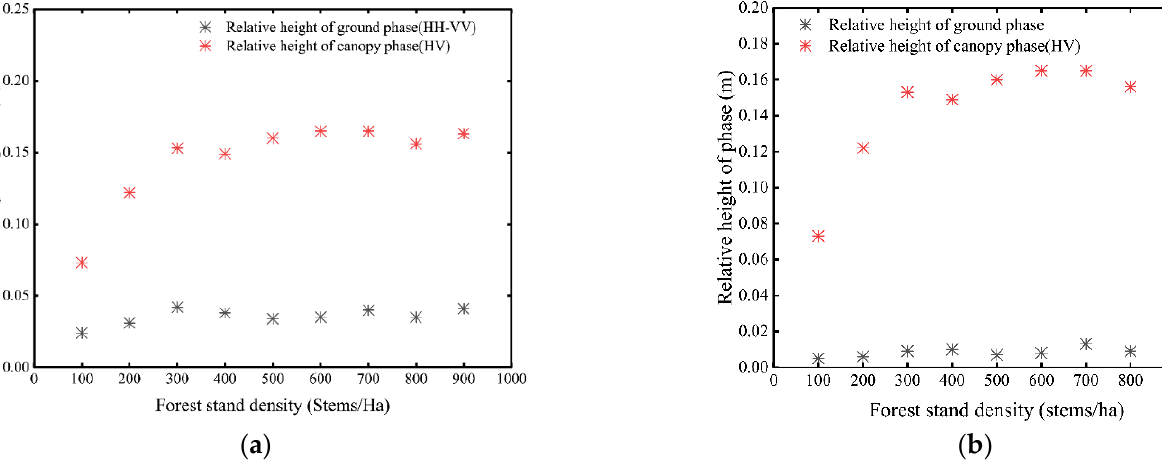
Figure 9. Relative heights of canopy phase center and ground phase center. ( a ) DEM difference method ( b ) RVoG ground phase method.